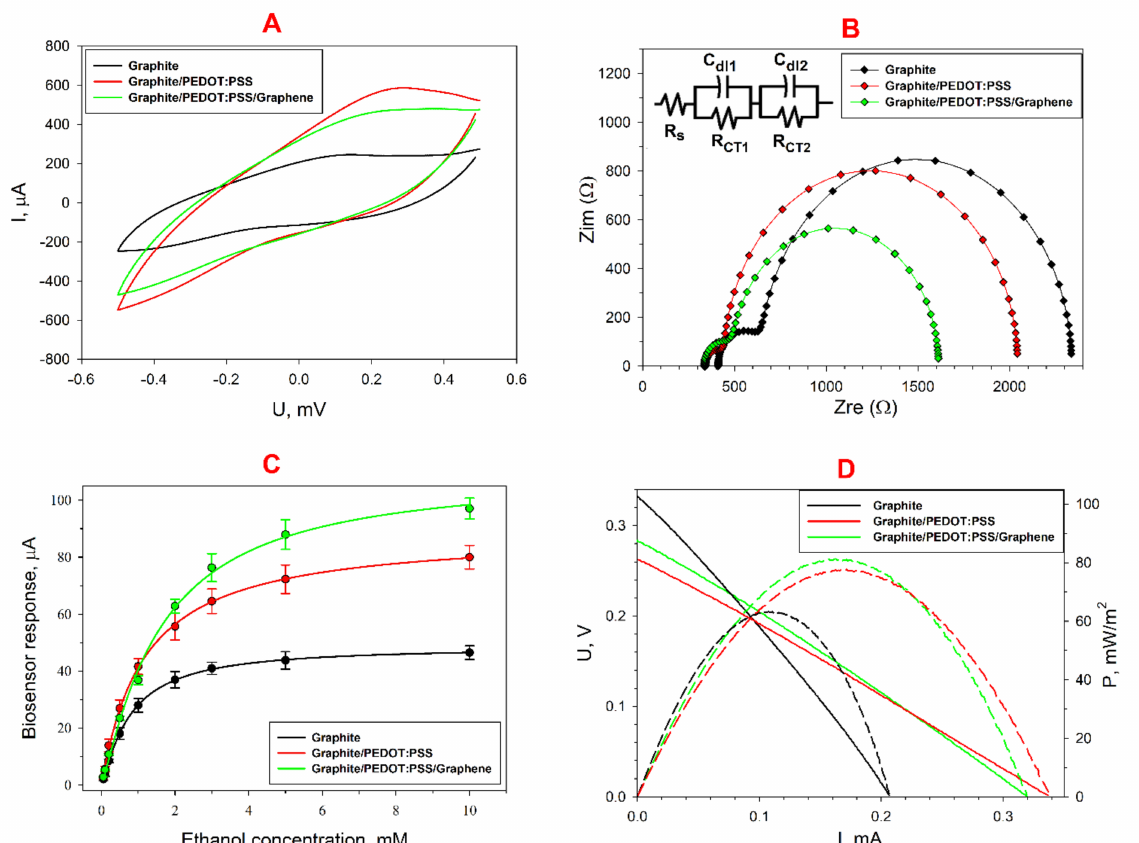
Figure 3. Electrochemical characteristics of the biocomposite modified with various types of PE- DOT:PSS: ( A ) CVA of bioanodes at a scan rate of 3 mV s − 1 ; ( B ) Nyquist plots for bioanodes; ( C ) cali- bration curves for ethanol for various types of bioanodes; ( D ) typical polarization curves obtained from cyclic voltammograms and power density